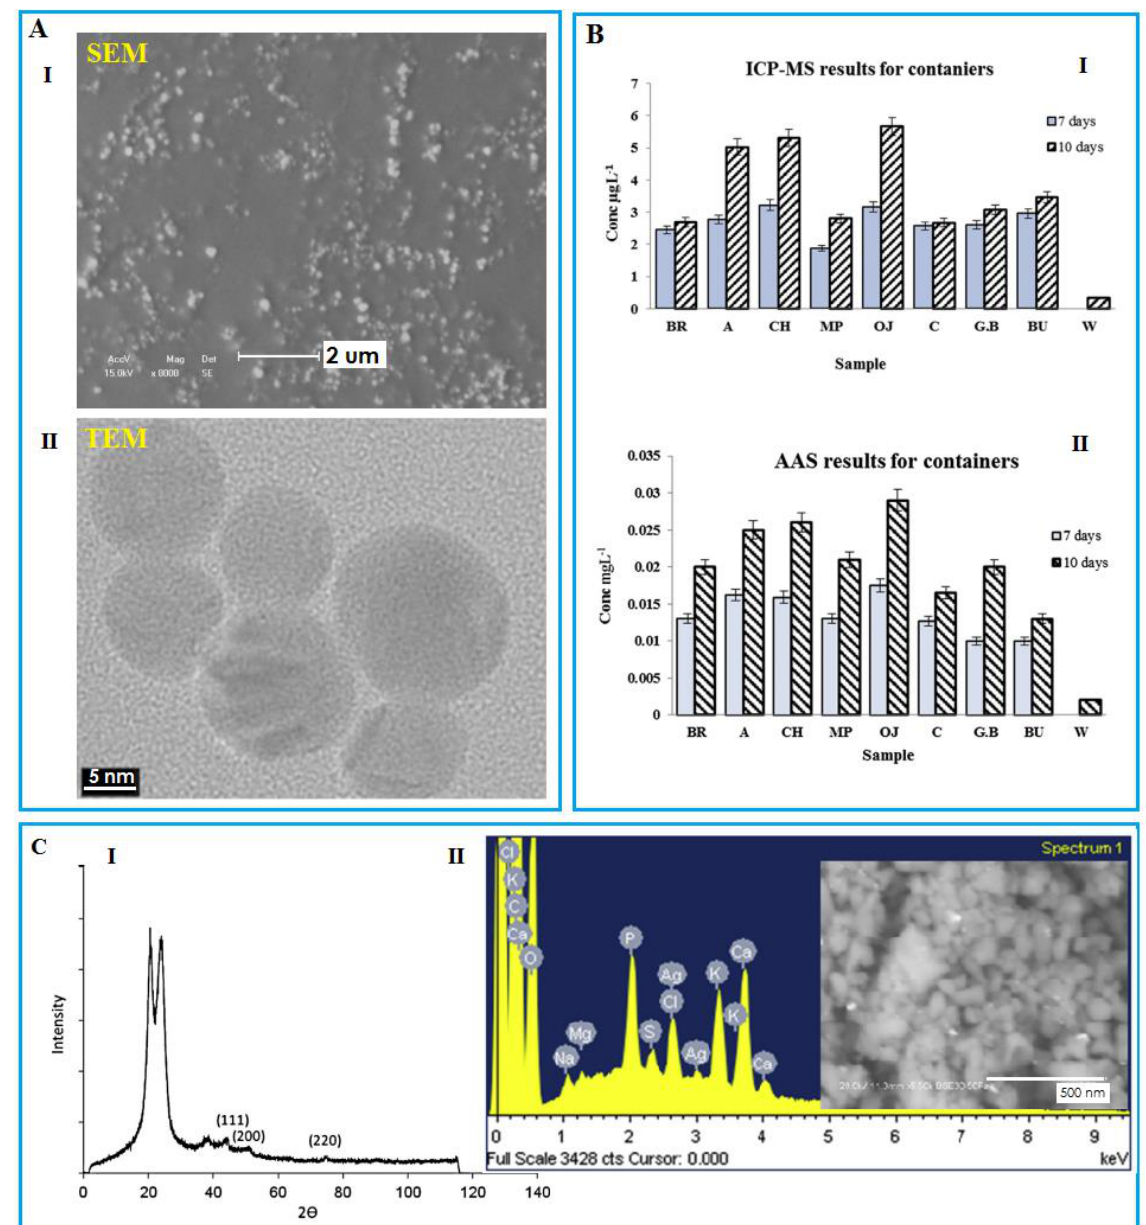
Figure 4. ( A ) I: SEM illustration of the AgNPs synthesized by the modified polysaccharide. Reprinted with permission from [82]. Copyright 2017 Elsevier; II: TEM image shows the migration of AgNPs detected from an orange juice sample under storage by a nano-silver coated film packaging at 40 °C for 10 days. Reprinted with permission from [81]. Copyright 2015 Elsevier. ( B ) I: Inductively coupled plasma mass spectrometry (ICP-MS); II: Atomic absorption determination of Ag from different food samples stored using nanosilver containers for 7 and 10 days at 40 °C. ( C ) I: XRD spectrum of nylon fabric treated by copper NPs. Reprinted with permission from [57]; II: EDS and SEM images indicate silver NPs as white spots detected inside the milk powder stored using nanosilver coated film packaging for 10 days at 40 °C. Reprinted with permission from [81]. Copyright 2015 Elsevier.